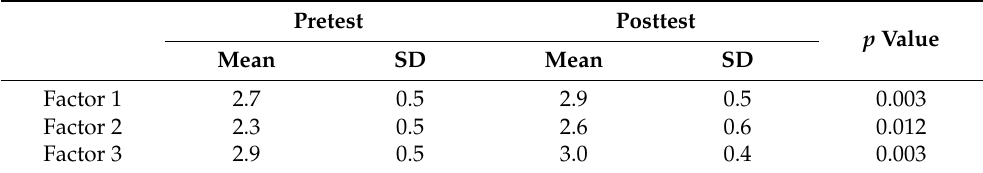
Table 6. CLA factor analysis pretest to posttest.